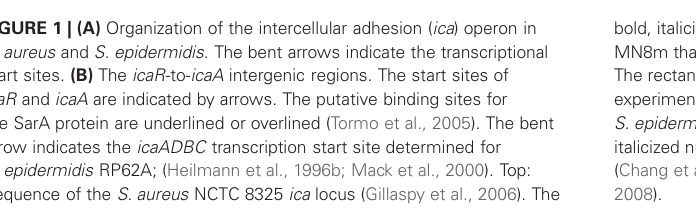
bold, italicized nucleotides indicate base pairs deleted in S. aureus MN8m that resulted in PIA/PNAG overproduction (Jefferson et al., 2003). The rectangle indicates the region bound by IcaR in DNase I protection experiments (Jefferson et al., 2003). Bottom: Sequence of S. epidermidis RP62A ica locus (Heilmann et al., 1996b). The bold, italicized nucleotides represent the highest affinity TcaR binding site (Chang et al., 2010). The rectangle indicates the IcaR binding site (Jeng et al.,